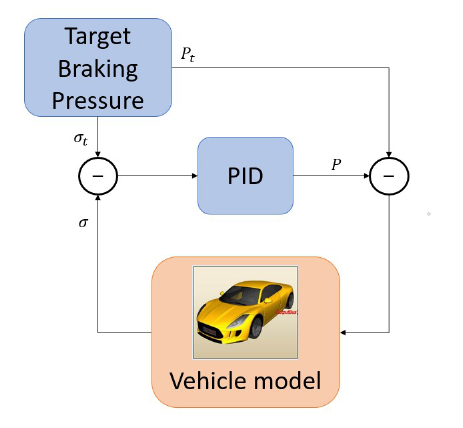
Figure 4. Longitudinal slip controller